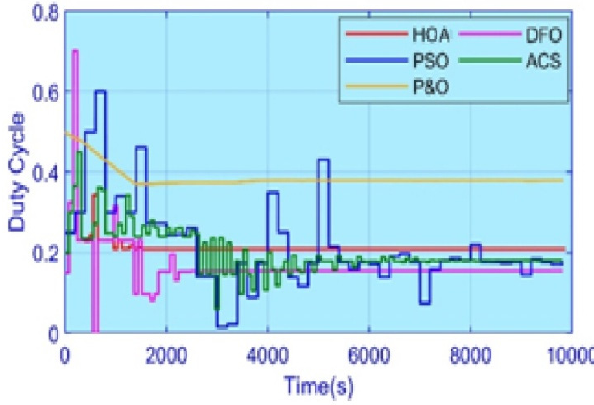
Figure 18. Comparison of the HOA duty-cycle for Case 3 .